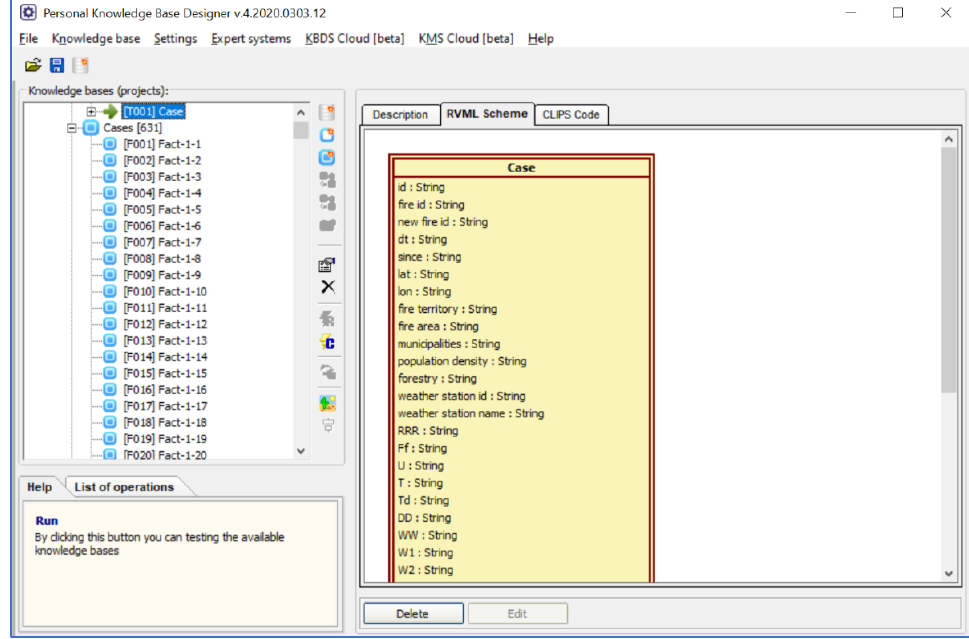
Figure 7. An example of a PKBD GUI form: description of a template (structure) for cases (631 forest fires for 2020). (dt, data; RRR, the amount of precipitation; Ff, wind strength; U, relative humidity of the air; T, air temperature; Td, dew point temperature; DD, wind direction (rumba); WW, current weather reported from the weather station; W1, past weather between observation dates 1; W2, past weather between observation dates 2).